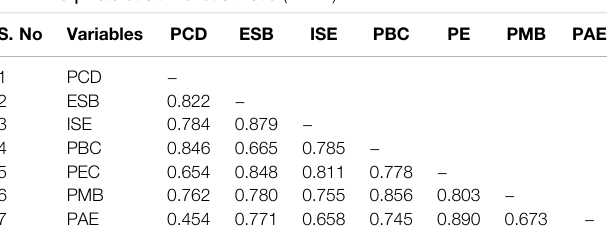
− the large section.